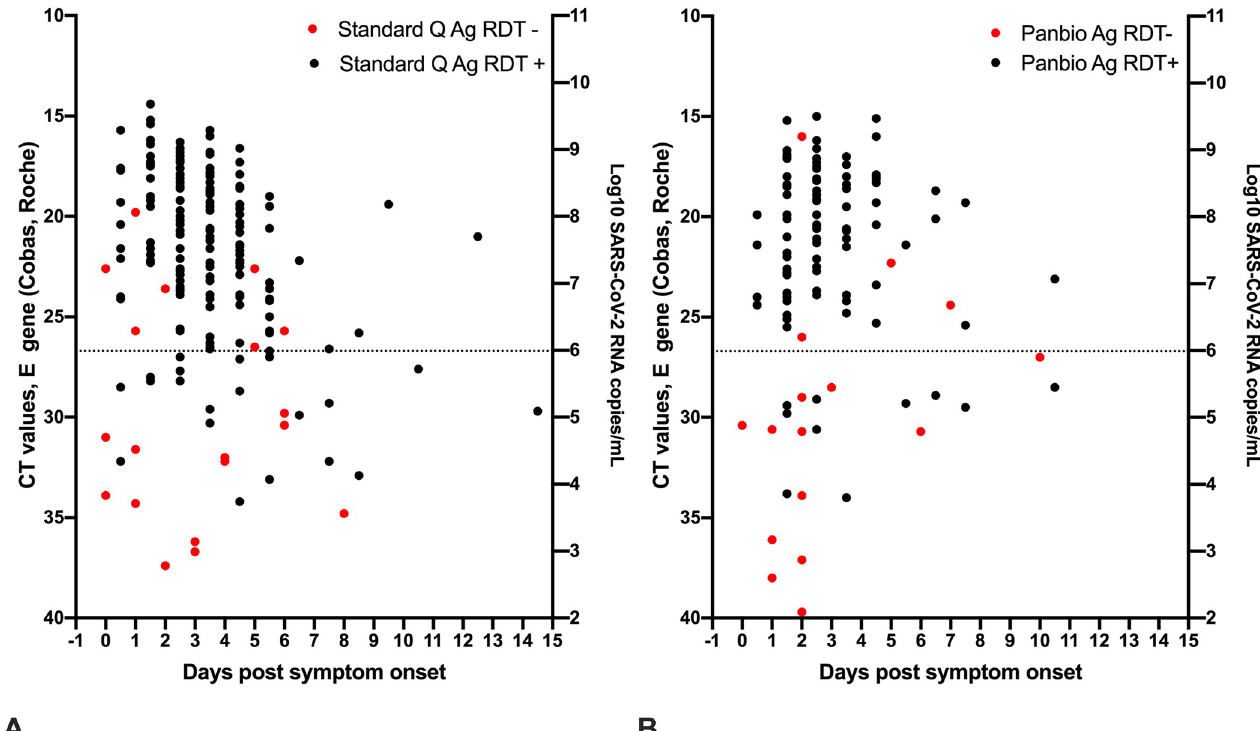
Fig 2. Ct values, viral load, days post symptom onset and Ag-RDT results for 190 patients tested with Standard Q ( A ) and 116 patients tested with Panbio ( B ) for which information on day of symptom onset was available. Dotted line: Ct value of 26.7 or 1E6 SARS-CoV-2 RNA copy numbers/mL.